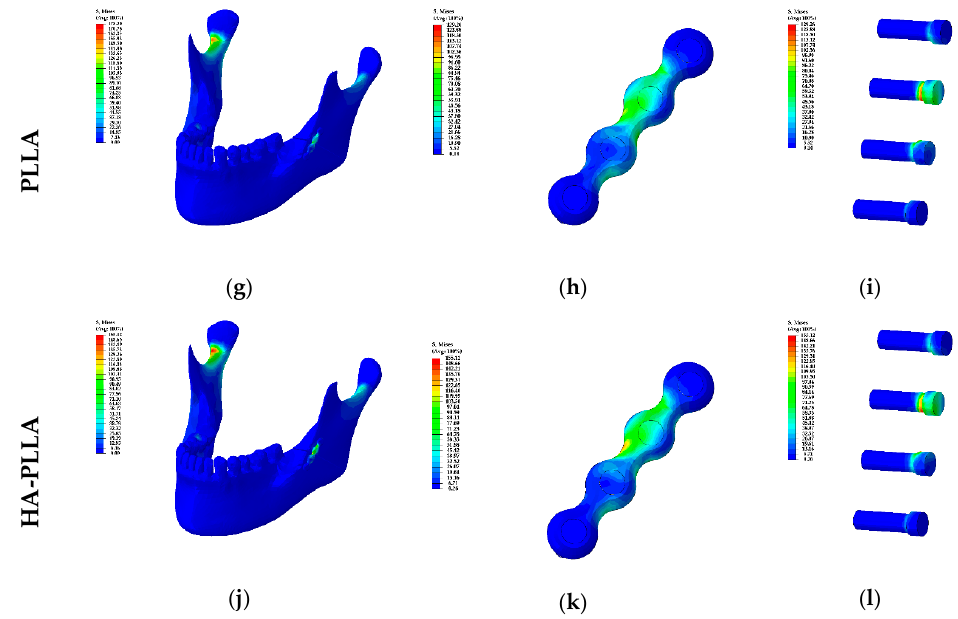
Figure 2. Visualization of Table 2: the distribution of stress in plate and screw systems based on materials is demonstrated from ( a ) to ( l ). The left column presents the stress on the mandible and the fixations while the middle column presents the stress of fixations: mini-plates and screws. The right column presents the stress on the screws solely.